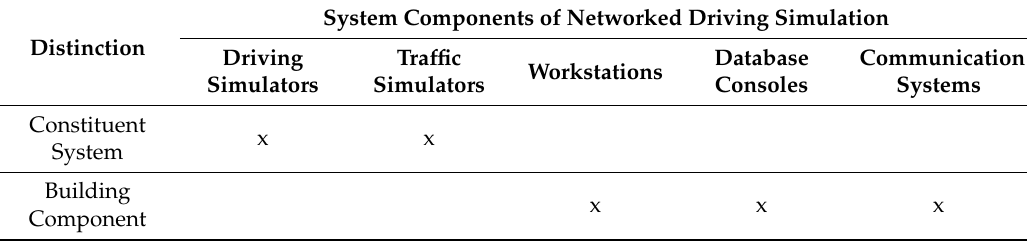
Table 8. Distinction between constituent systems and building